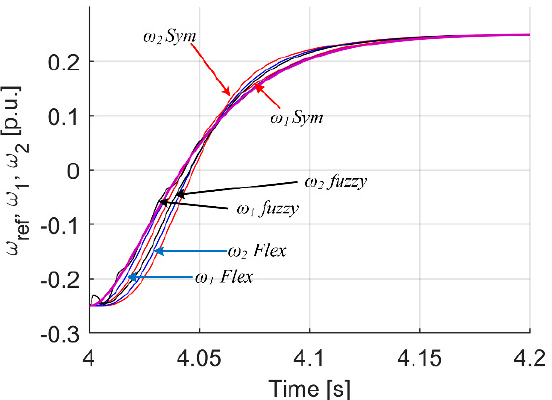
Figure 12. Transients of motor, load and reference speed for analyzed controller cases.